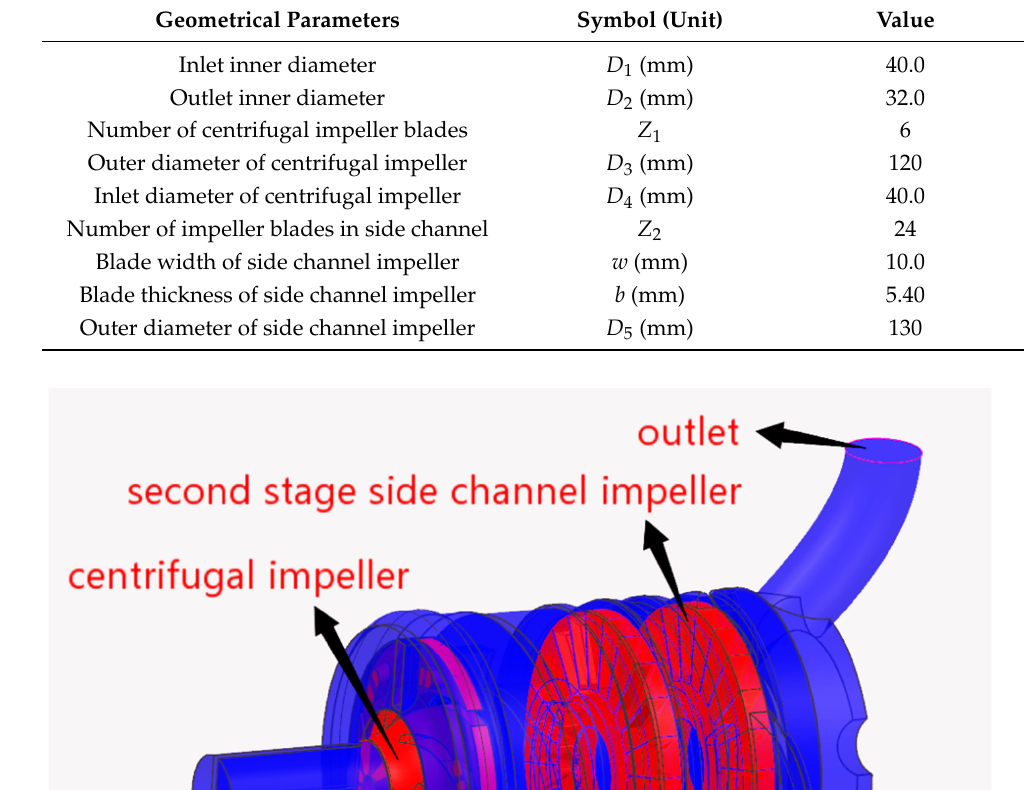
( b ) Figure 2. Partial mesh view of the flow domain: ( a ) centrifugal impeller; ( b ) side channel impeller. To determine the appropriate number of grids for the numerical simulations, a grid independence test was carried out based on the SST model. As shown in Figure 3, when the number of grids reached 30 million, a change in the head resulted, with a number of grids that was not obvious, but the efficiency increased steadily. At the same time, as shown in Figure 4, the Y + of the main flow part was basically less than 30, while most parts of the side channel pump impeller were less than 5. This met the requirements of calculation accuracy; thus, all of the simulations for the study were meshed using these methods, for consistency.